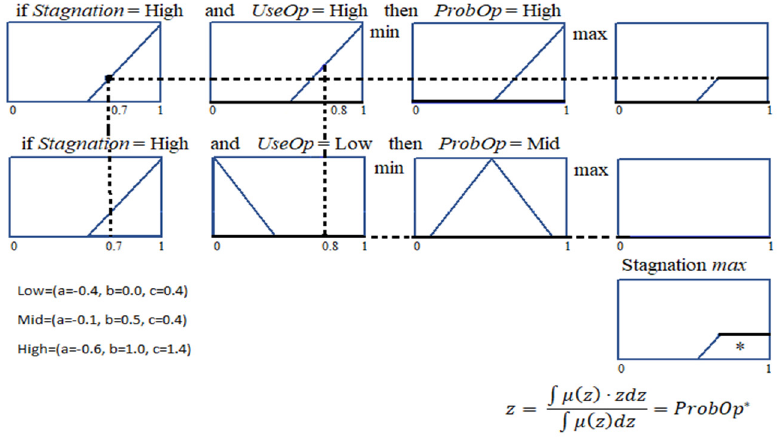
Figure 5. Mamdani Fuzzy Inference System used in the fuzzy controller.